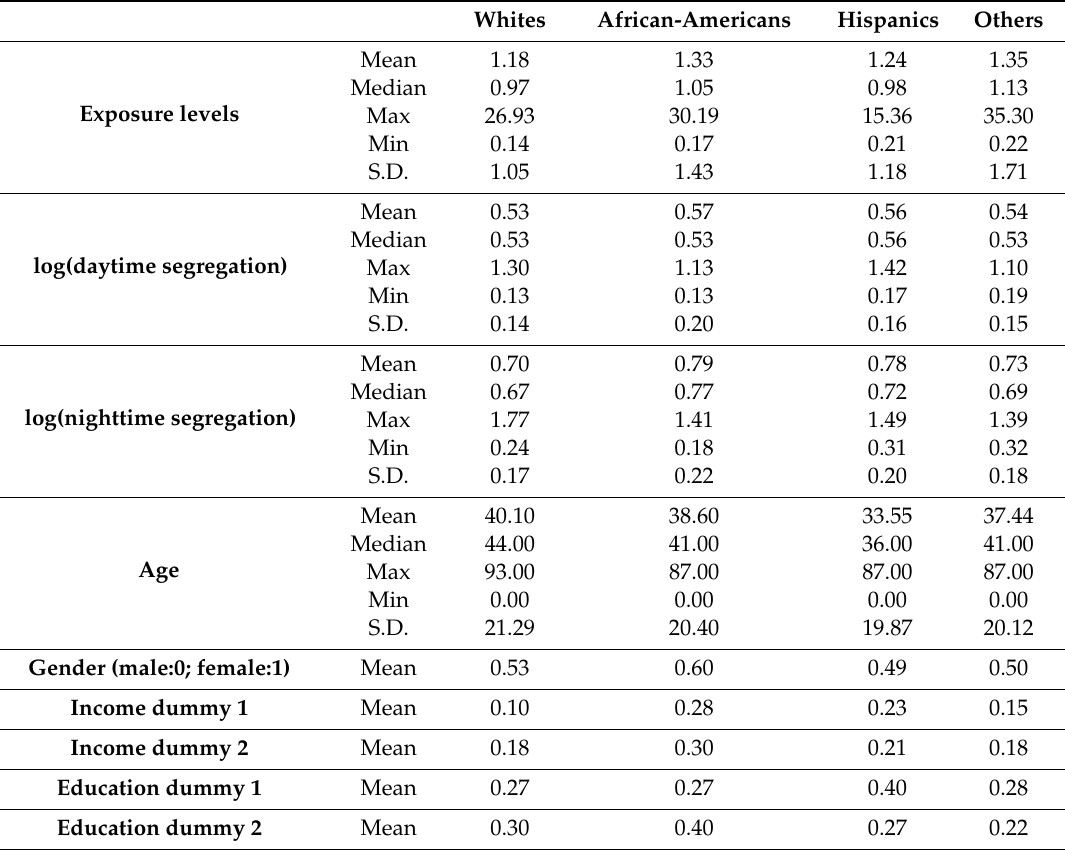
Table 2. Descriptive statistics for dependent and independent